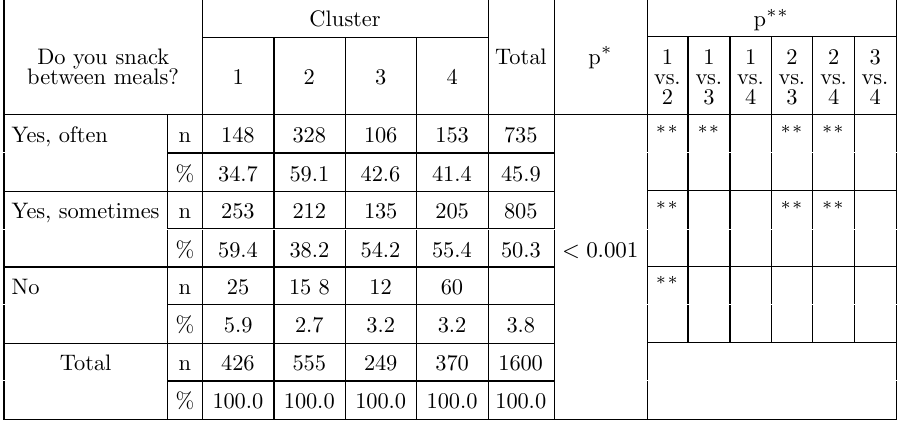
Table 6. Snacking between meals among the surveyed students in separate clusters Cluster p